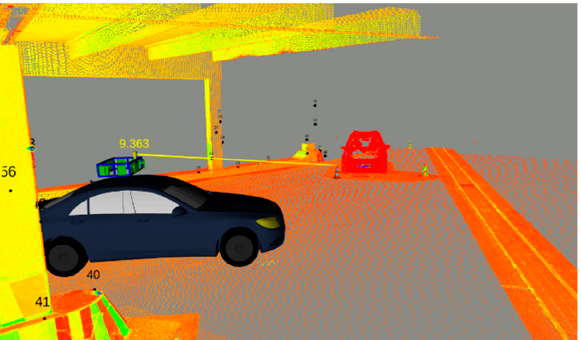
Figure 7. Visualization of the point cloud, which represents the static digital twin of the test scene and the moving digital twin of the car.